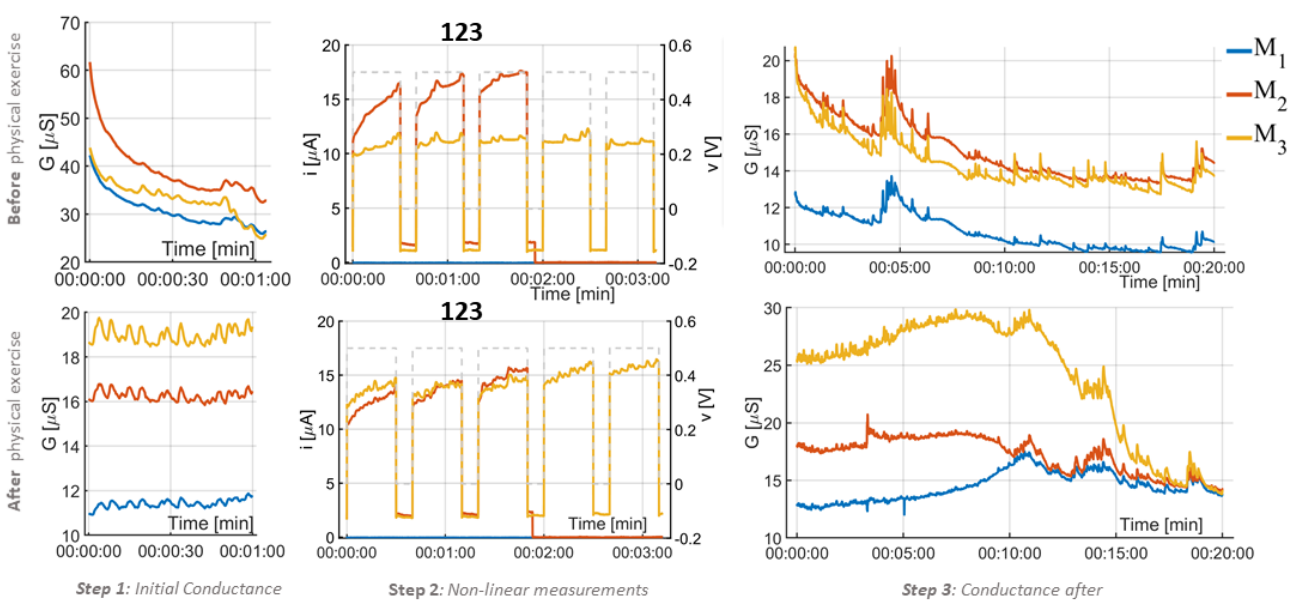
Fig. 6: Recordings of test subject “C” before (top plots) and after physical exercise (bottom plots) shown for the skin under all three measurement electrodes (M 1 , M 2 , and M 3 ). For this subject, both measurements were done with number 123. This subject was electrodermal active at the